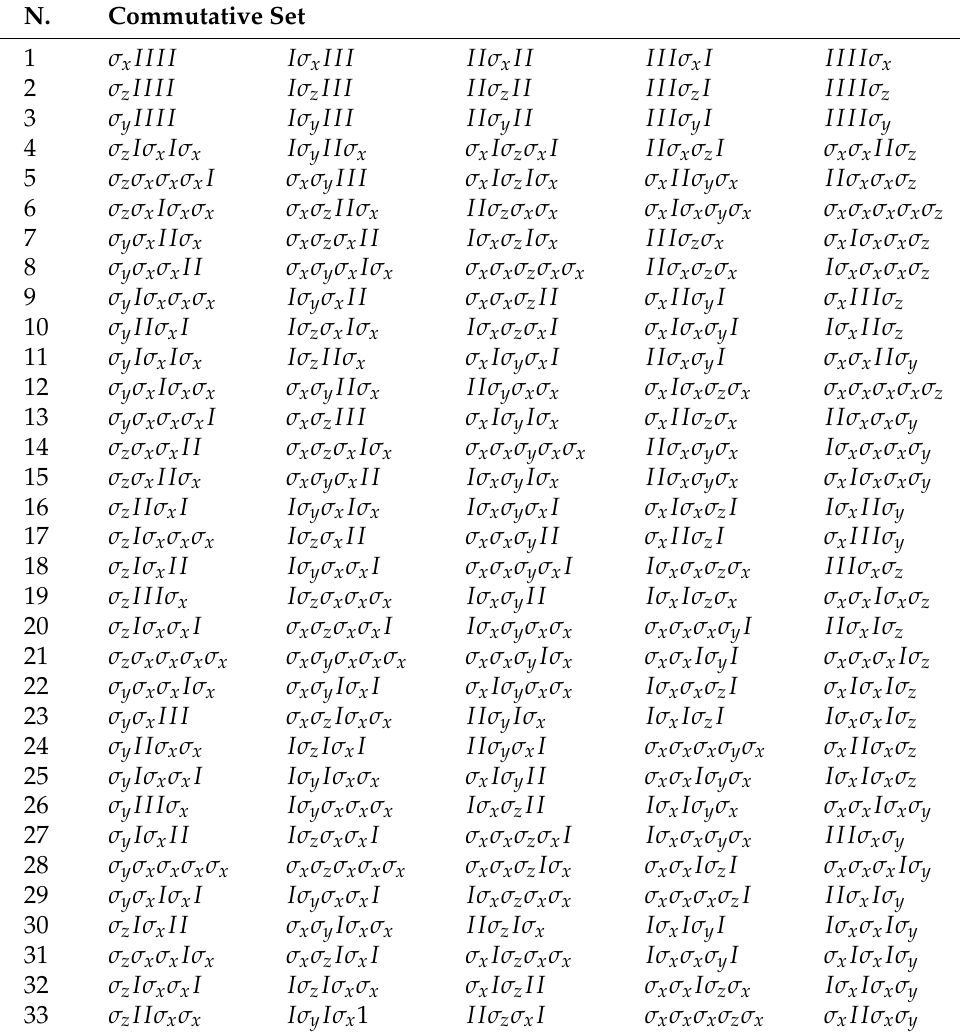
Table A1. Commutative sets (generators) whose eigenstates form MUBs of degree 33.